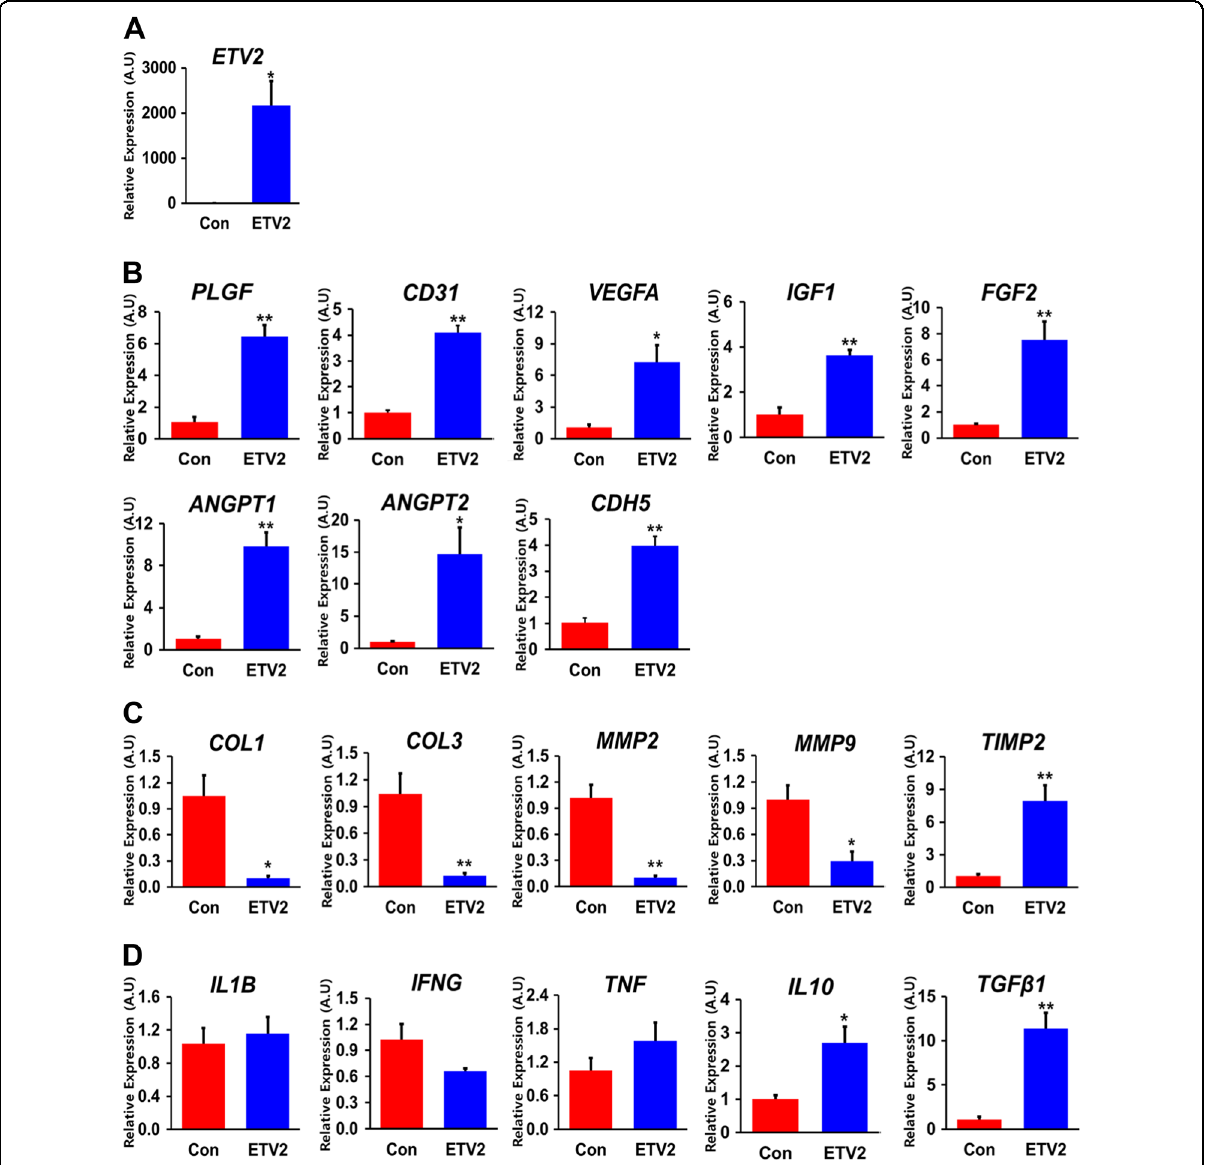
Fig. 2 Delivery of lentiviral ETV2 into MI hearts enhances the expression of pro-angiogenic genes but decreases the expression of genes involved in fi brosis and in fl ammation. Heart tissues harvested 7 days after injection of lentiviral particles of ETV2-Ires-VENUS or control into MI hearts were subjected to qRT-PCR analyses. a ETV2 gene, b angiogenesis, c fi brosis, and d in fl ammation. The y -axis represents relative mRNA expression of target genes to GAPDH. A.U. indicates arbitrary units. * p < 0.05 and ** p < 0.01 compared to control group, n =